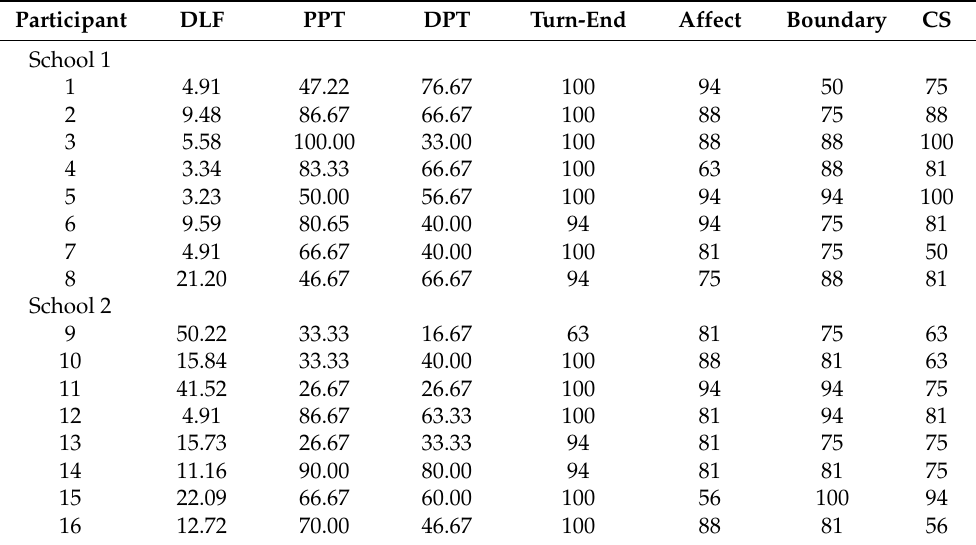
Table 1. DLF scores (in Hz) and percent correct scores for each of the seven experimental conditions. Participant DLF